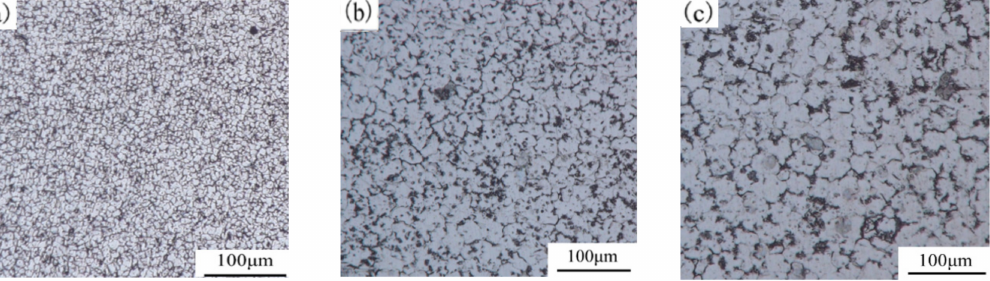
Figure 7. Grain microstructure at the top of the layer fabricated using different currents. ( a ) Grain microstructure at the top (180 A). ( b ) Grain microstructure at the top (190 A). ( c ) Grain microstructure at the top (200